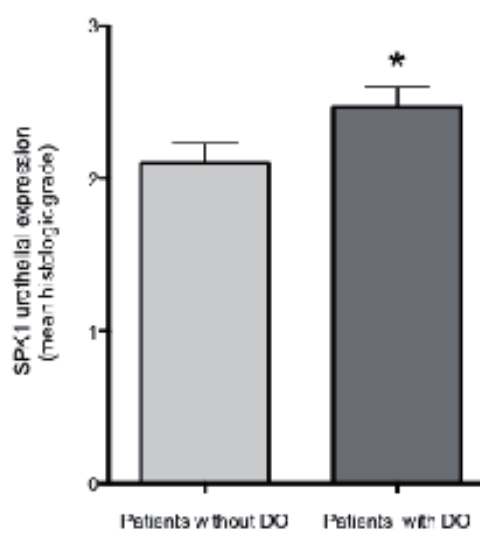
figure 3 - spK1 expression and detrusor overactivity.